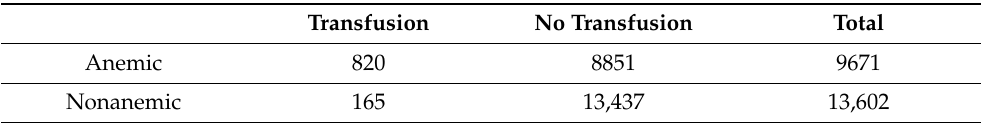
Table 2. Adapted from Henke Study [20] comparing periprocedural transfusion between preoperative anemic and nonanemic